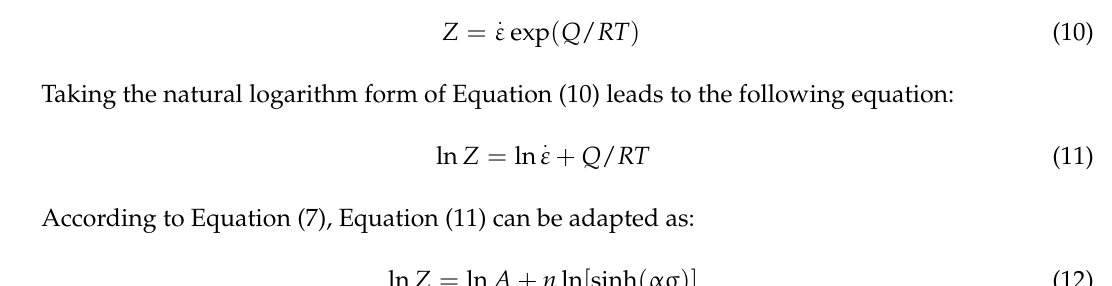
Fig ure 5. The comparison of Q values among different aluminum alloys. Figure 5. The comparison of Q values among different aluminum alloys.